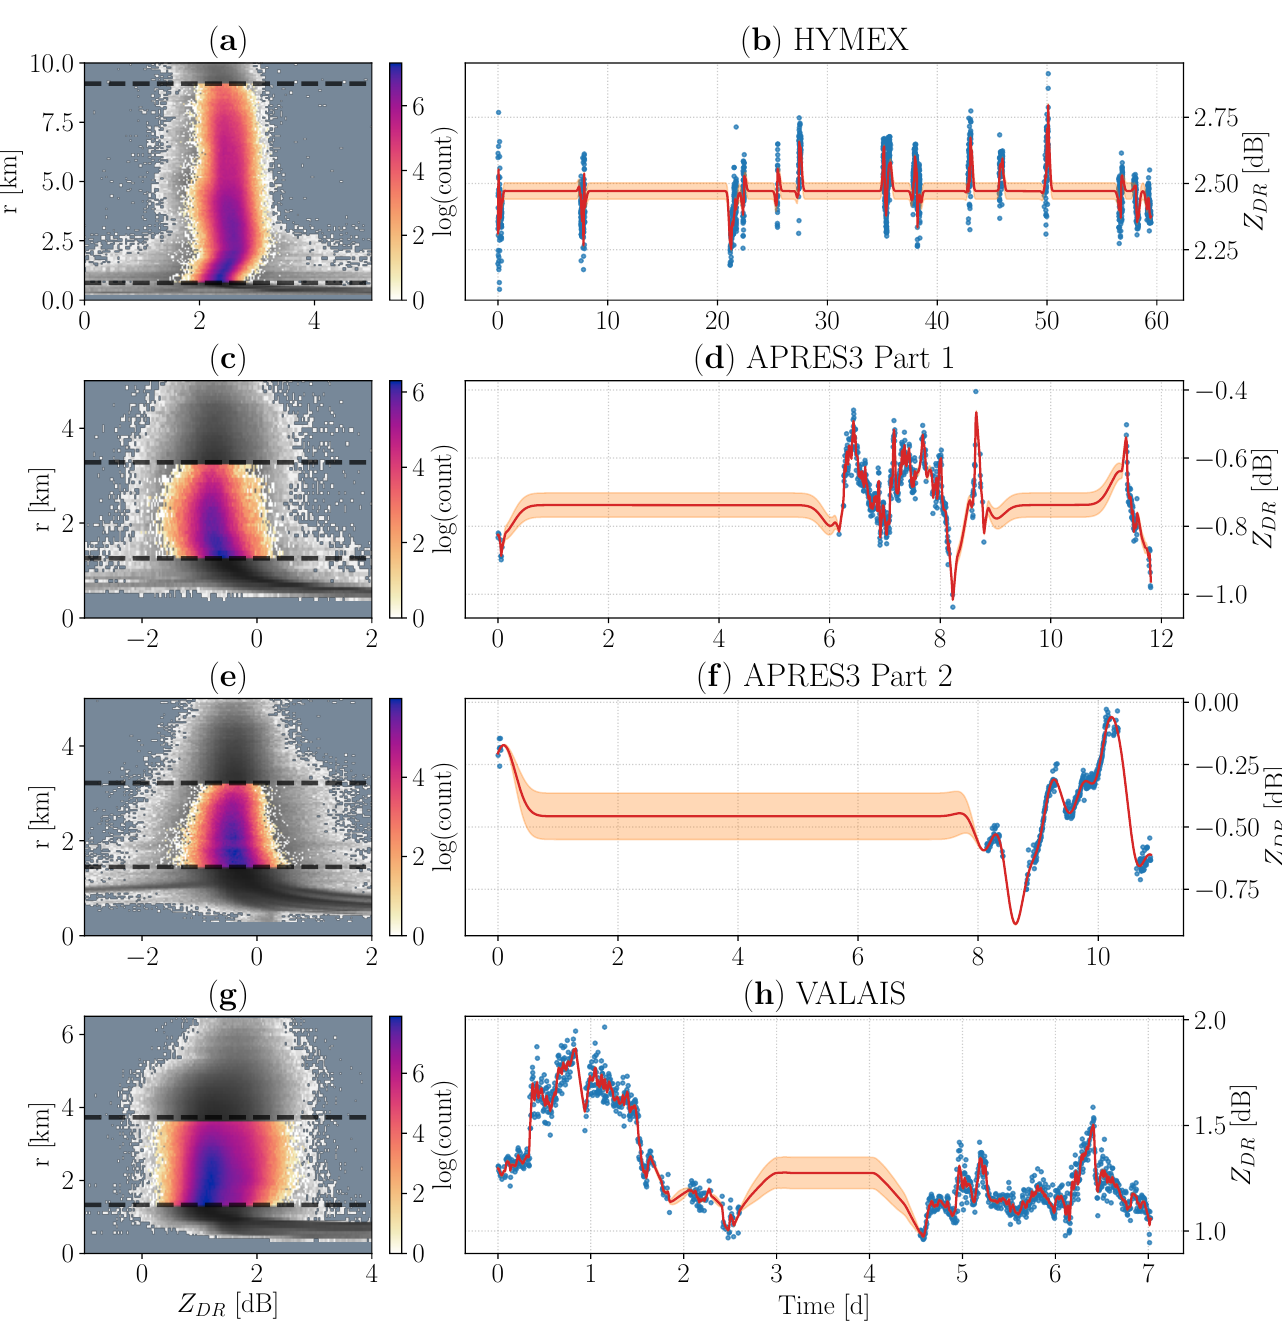
Figure 8. The calibration applied to the remaining datasets, except for DAVOS. ( a ) 2-dimensional histogram of the couples ( Z ) recorded during the HYMEX campaign, repeated twice: first using all the measurements, displayed in grayscale, DR , r and then including only the couples used for the calibration, shown in color with its colorbar on the left side. The horizontal black dashed lines indicate the borders of the region selected by the algorithm for extracting the median values, input for the kriging interpolation. ( b ) Temporal evolution of the calibration for the HYMEX campaign (red line) and its confidence interval (in orange) superimposed to the median differential reflectivity at each time step (blue dots). The plot follows the same structure as Figure 5. Panels ( c , e , g ) display the same information as panel ( a ) for the campaigns of VALAIS, APRES3 Part 1 and APRES3 Part 2, respectively. Similarly, panels ( d , f , h ) show analogous plot as panel ( b ) for the same three